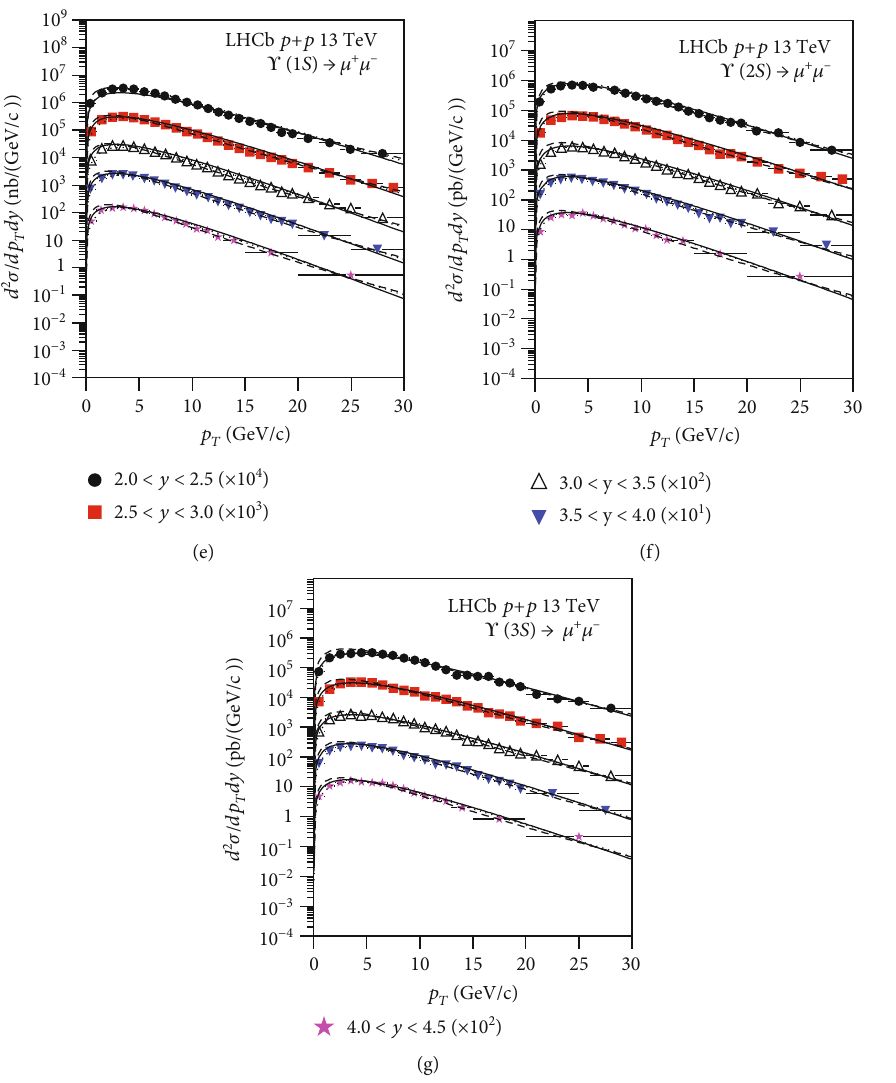
dy , of (a, d, e) Y ð 1 S Þ ⟶ μ + μ − , (b, f) Y ð 2 S Þ ⟶ μ + μ − , and (c, g) Y ð 3 S Þ ⟶ μ + μ − in (a – c) and Figure 6: Transverse momentum spectra, d 2 σ / dp T (e – g) p + p and (d) p + Pb collisions at (a – c) 8, (d) 8.16, and (e – g) 13 TeV. The symbols represent the experimental data measured by the LHCb Collaboration [25 – 27]. The rapidity intervals for panels (a – c) and (e – f) are 2 : 0 < y < 2 : 5 , 2 : 5 < y < 3 : 0 , 3 : 0 < y < 3 : 5 , 3 : 5 < y < 4 : 0 , and 4 : 0 < y < 4 : 5 . The rapidity intervals for (d) are 1 : 5 < y < 2 : 0 , 2 : 0 < y < 2 : 5 , 2 : 5 < y < 3 : 0 , 3 : 0 < y < 3 : 5 , and 3 : 5 < y < 4 : 0 . Di ff erent sets of data points are scaled by di ff erent amounts shown in the panels. The data points are fi tted by the Erlang distribution (Eq. (3)), the Hagedorn function (Eq. (4)), and the Tsallis-Levy function (Eq. (6)) by the solid, dashed, and dotted curves,